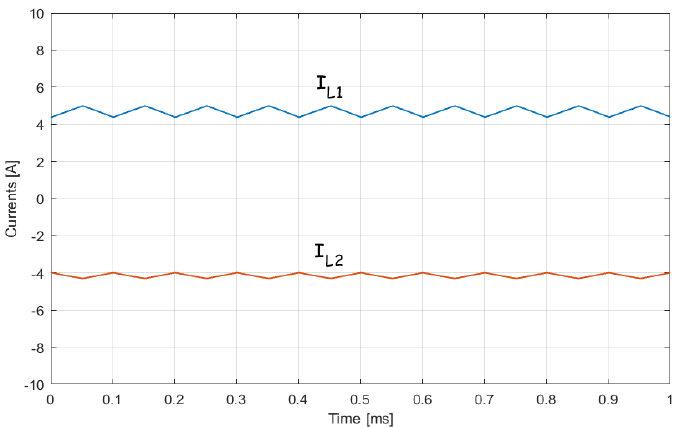
Figure 6. Simulation results of the L 1 and L 2 inductor currents in buck mode.